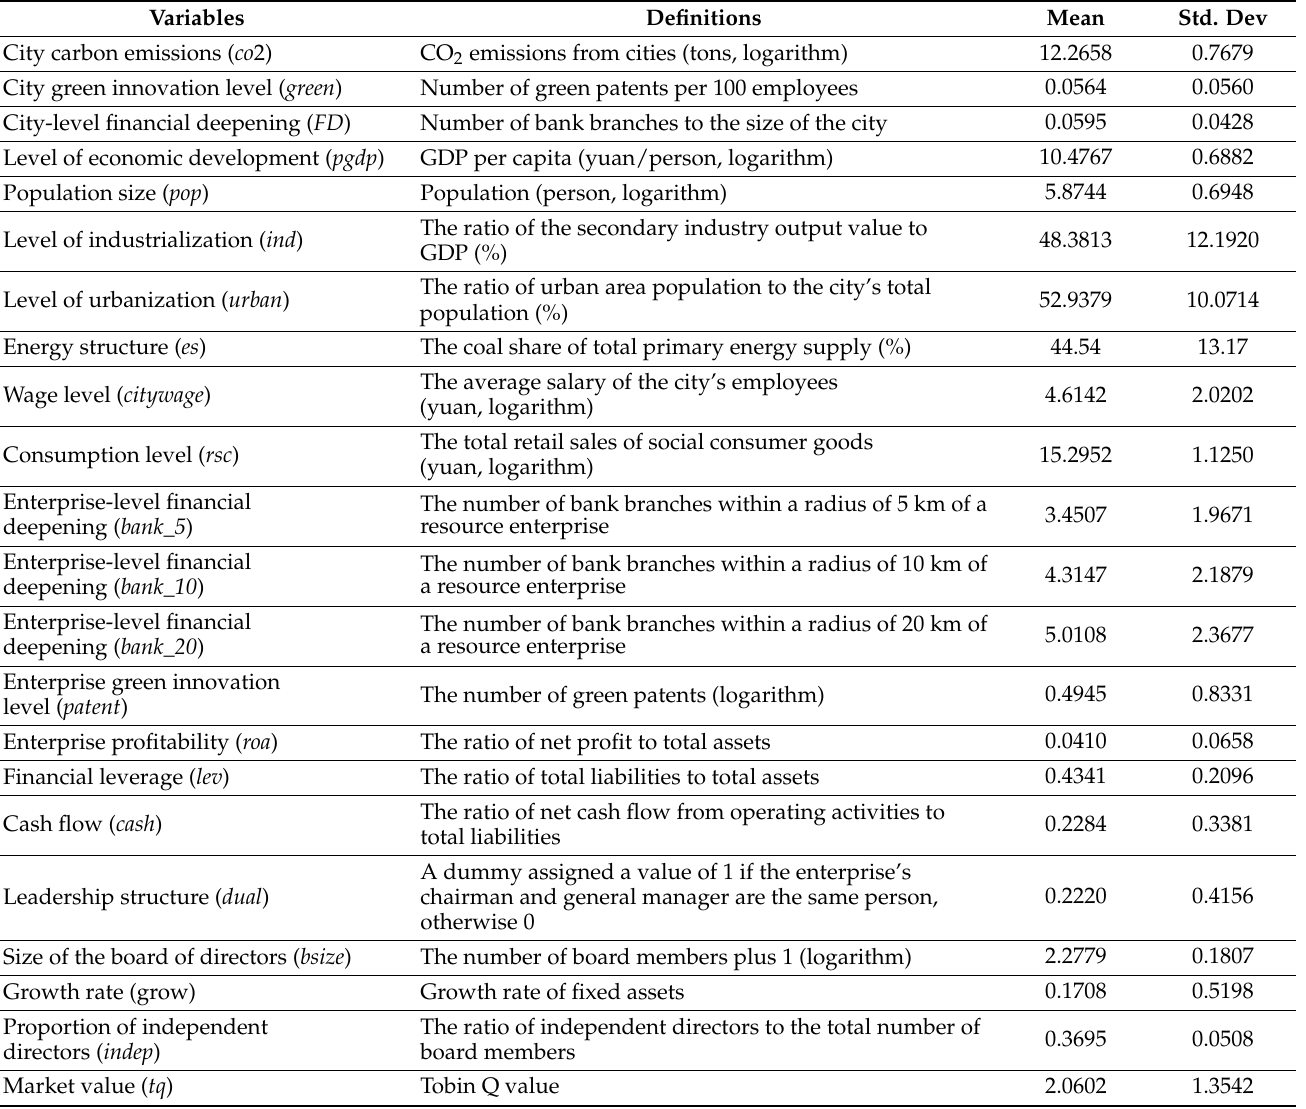
Table 1. Descriptive